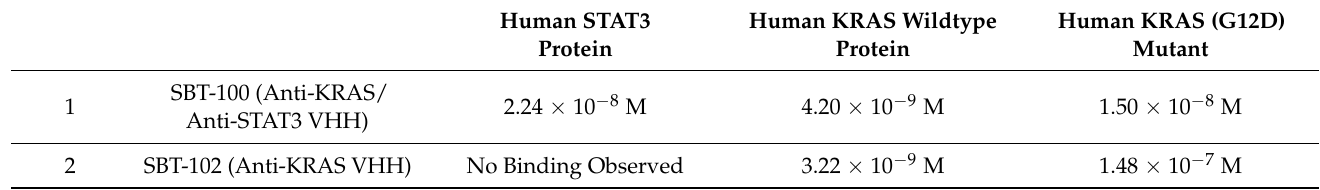
Table 1. Binding affinity of SBT-100 for human STAT3 and KRAS determined using Biacore 3000. Human